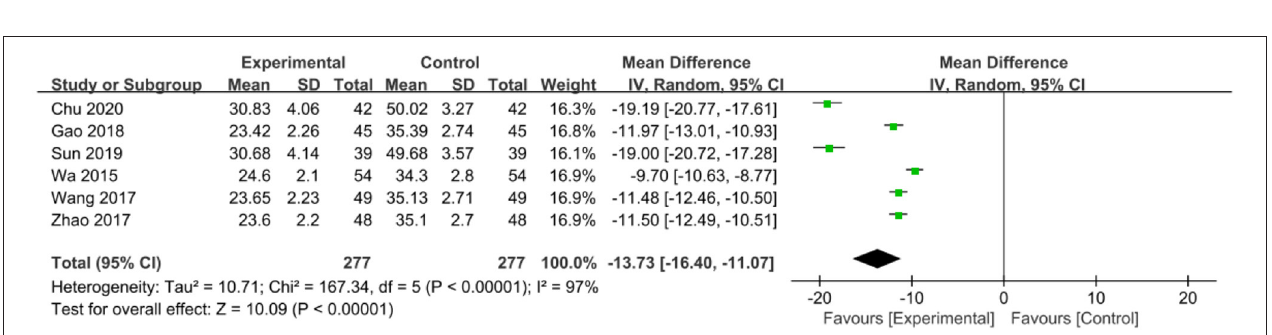
FIGURE 11 | Forest plots of ALT associated with experimental group (parenteral or enteral nutrition group supplemented with Gln) vs. control group (conventional nutrition group). I 2 tests and P are the criteria for the heterogeneity test, (cid:7) , pooled mean difference; — (cid:4) —, mean difference, and the edges of (cid:7) , 95% CI.